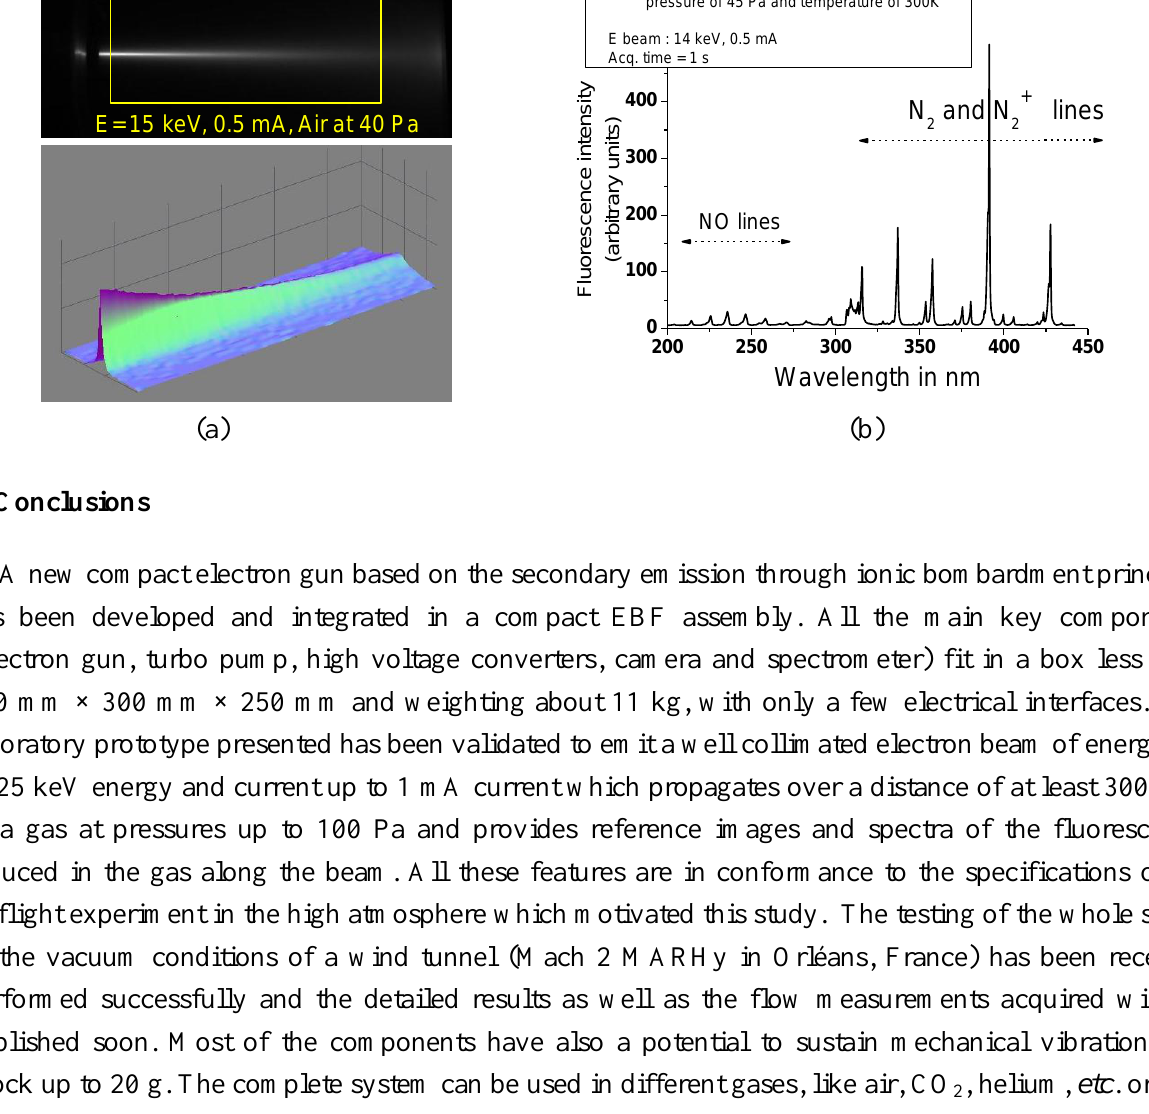
Figure 7. Examples of typical acquisitions obtained with the EBF system. (a) CCD image (top) of the fluorescent beam in air gas with typical dispersion and attenuation shown in the 3-D trace (bottom). (b) EBF spectrum in a gas mixture of N